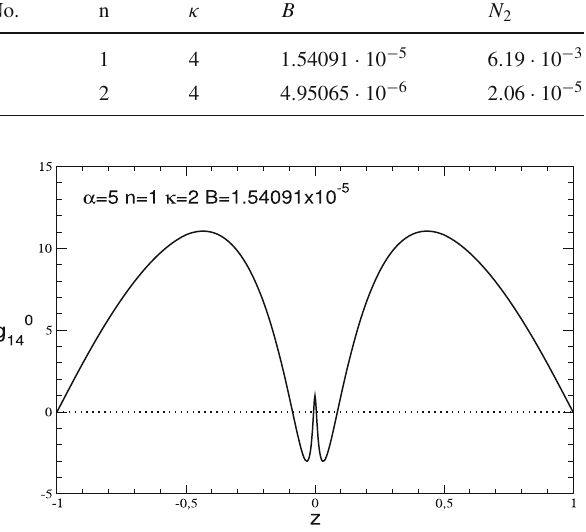
Table 2 Same as in Table 1, for the abnormal states with κ = 4 No.